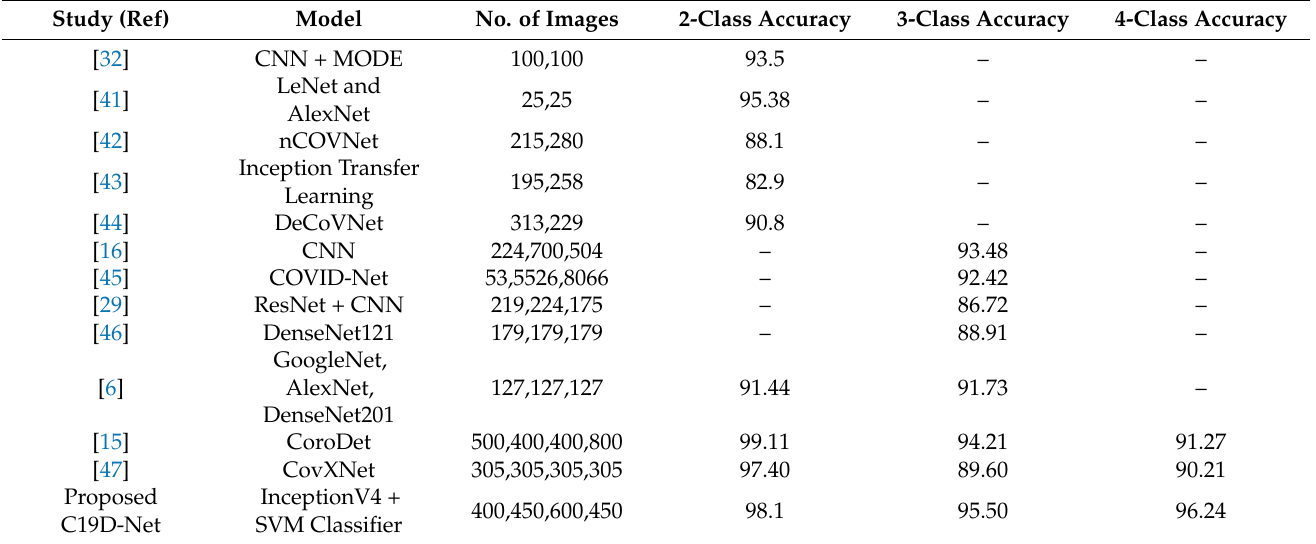
Table 9. Classification accuracy of proposed C19D-net model with other existing